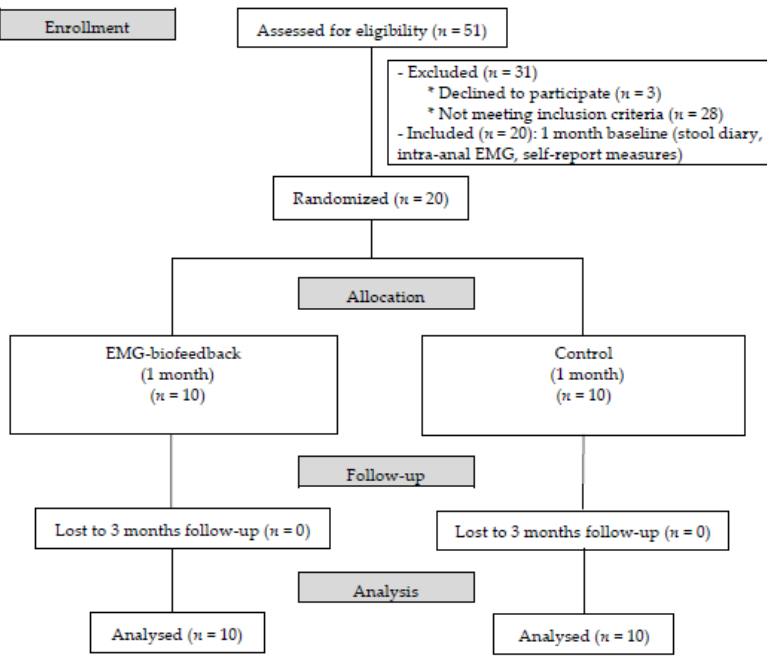
Figure 1. CONSORT flow diagram.